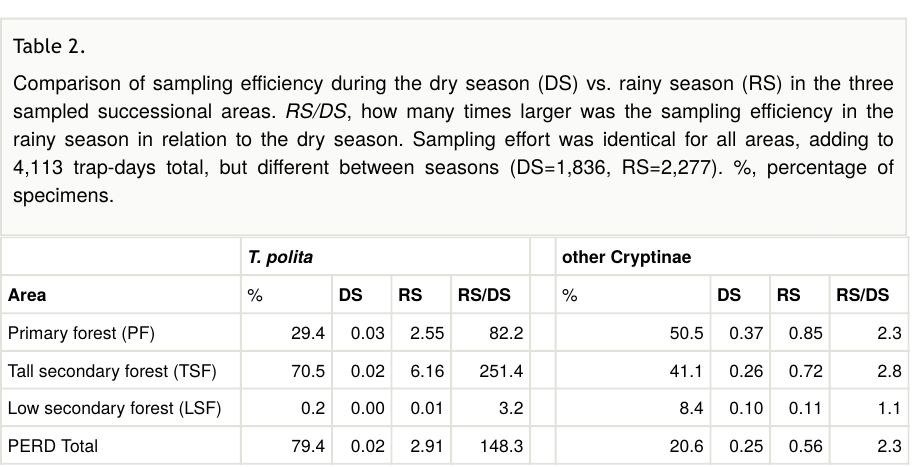
The seasonal dominance of T. polita in the park was not a happenstance: it occurred repeatedly through the years (Fig. 4), as evidenced by its nearly uninterrupted numerical superiority in the samples (Table 3), and by its presence in 47.8% of the individual trap samples from the RS, against only 9.2% for the DS.